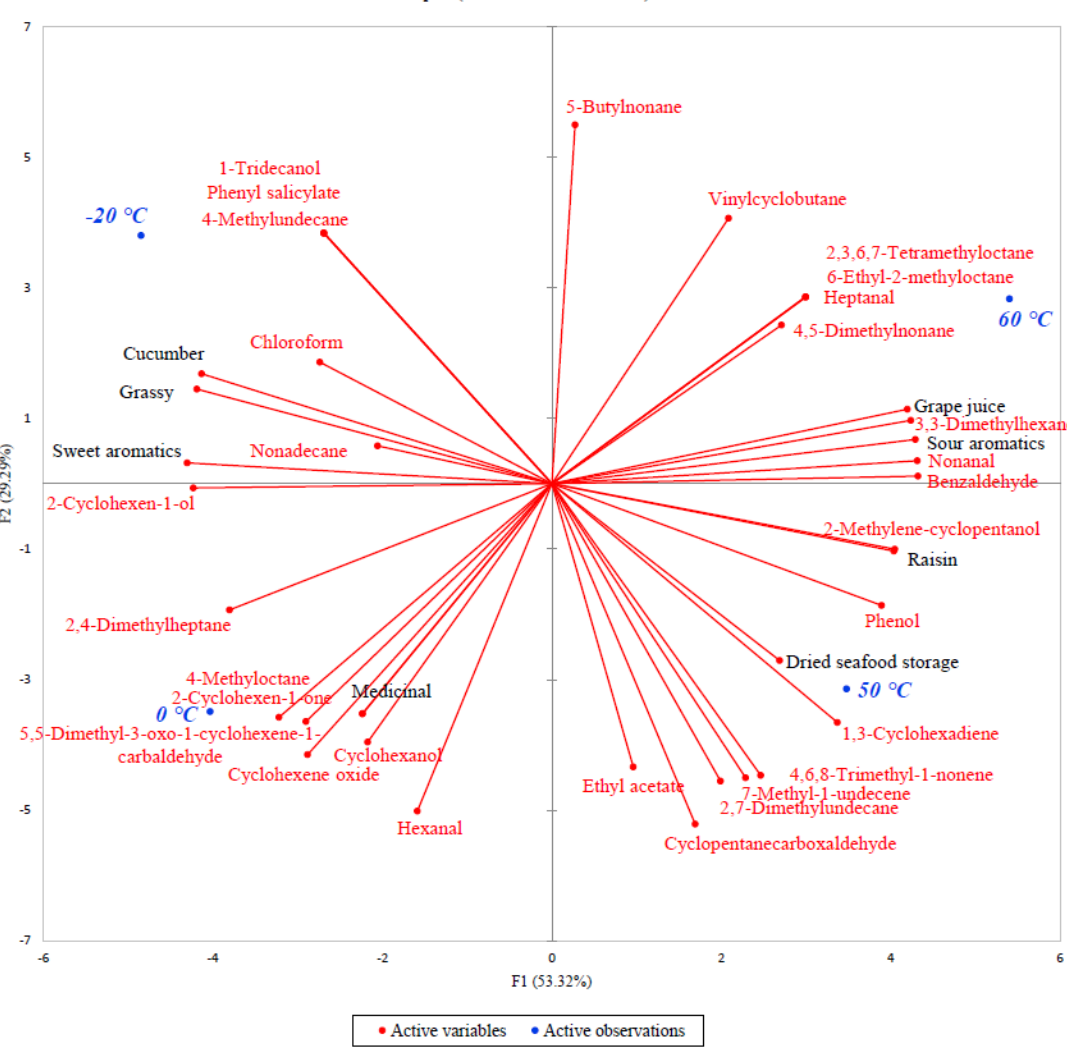
Figure 1. Principal component analysis biplot on volatile flavor analysis and descriptive sensory analysis analyses of mulberry fruits treated in different temperatures. 51